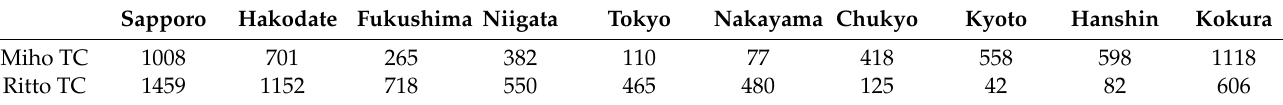
Figure 1. Locations of the 10 racecourses are shown in black circles ( • ) and 2 training centers (TC) are shown in white circles ( ○ ), in the Japan Racing Association. (Created using a map downloaded from Craft MAP [h tt p://www.craftmap.box-i.net] 11, November, 2022.) Table 1. The distance (km) between either training centers (TC) and the racecourses.